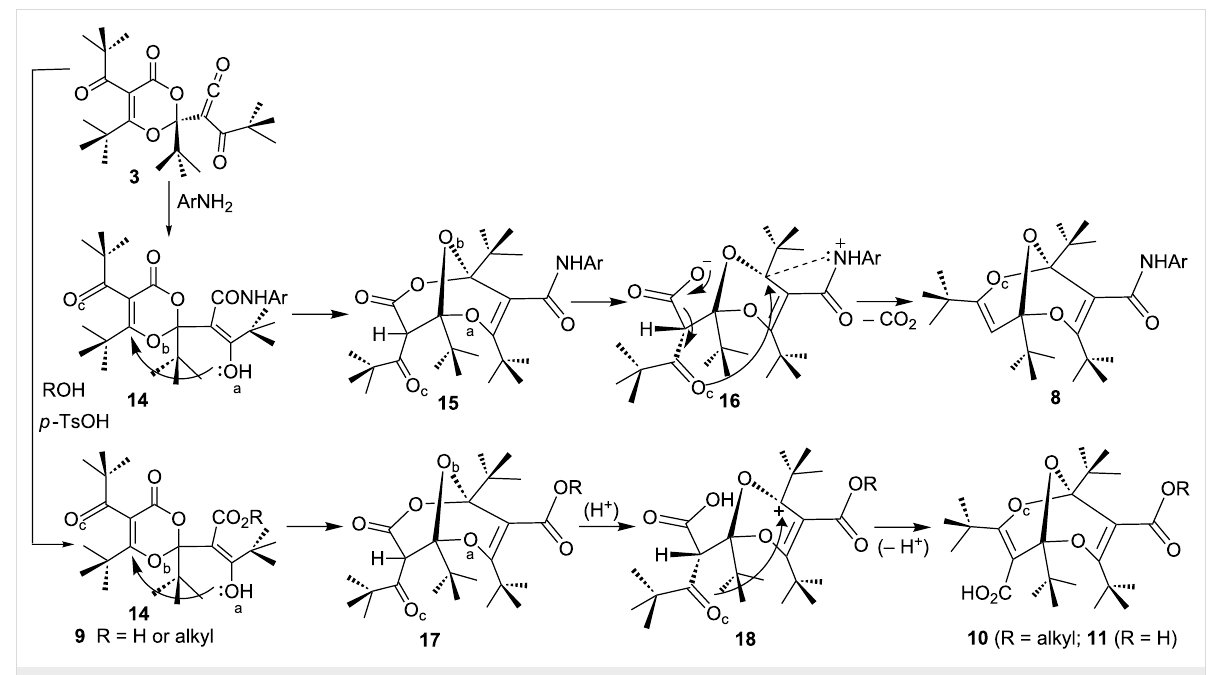
Scheme 4: Mechanisms of formation of bisdioxine acid derivatives from dimer 3